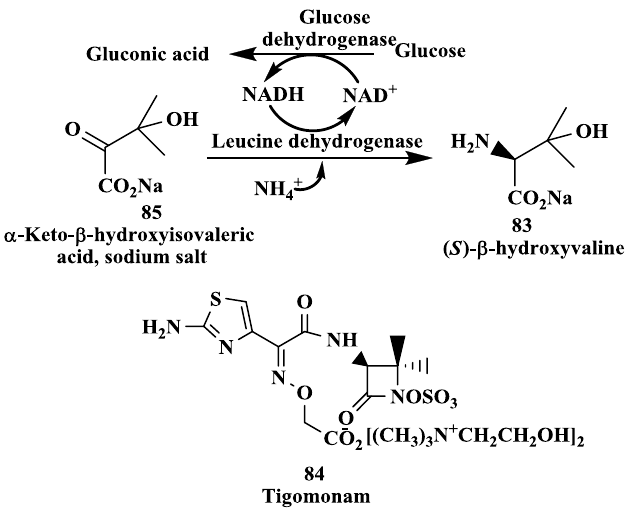
Figure 21. Tigemonam: Enzymatic synthesis of ( S